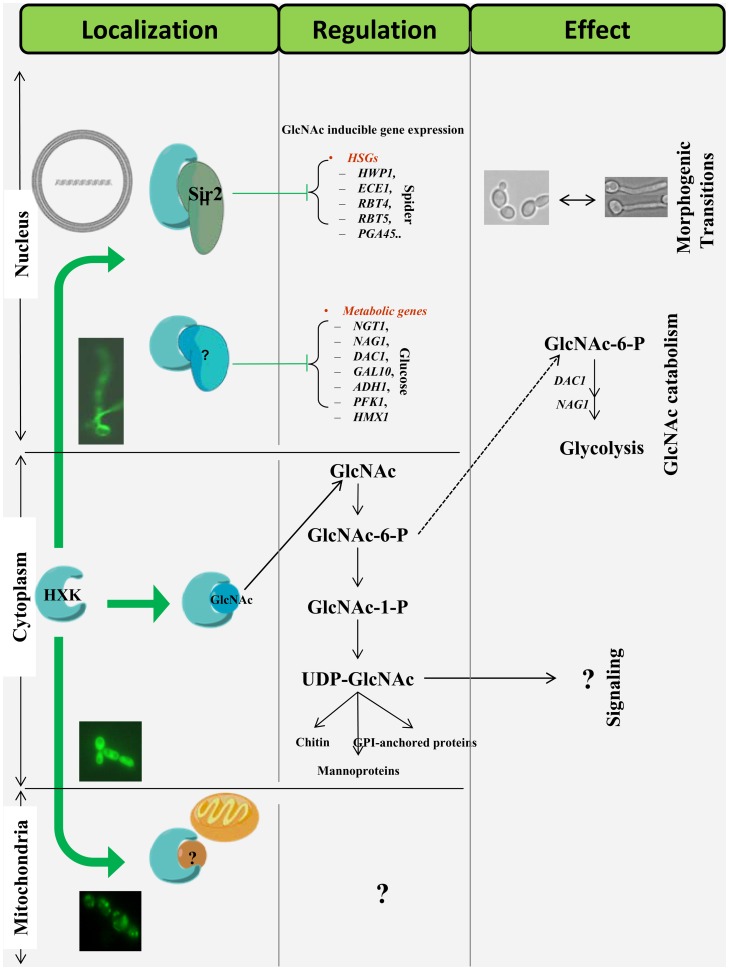
A brief overview of mode of action, localization, targets and downstream effects of Hxk1.The protein capable of multifarious localization migrates to nucleus where it possibly interacts with a Histone Deacetylase Sir2 to keep the HSGs in a repressed state. It probably partners again with Sir2 or some other proteins to repress the GlcNAc metabolic genes while still in nucleus. In cytoplasm Hxk1 phosphorylates GlcNAc to carry out the catabolism of this amino sugar and contributing probably to the overall UDP-GlcNAc pool within the cell. In presence of non-fermentable carbon sources like ethanol or glycerol the protein migrates to mitochondria where its mode of functioning is still not known.